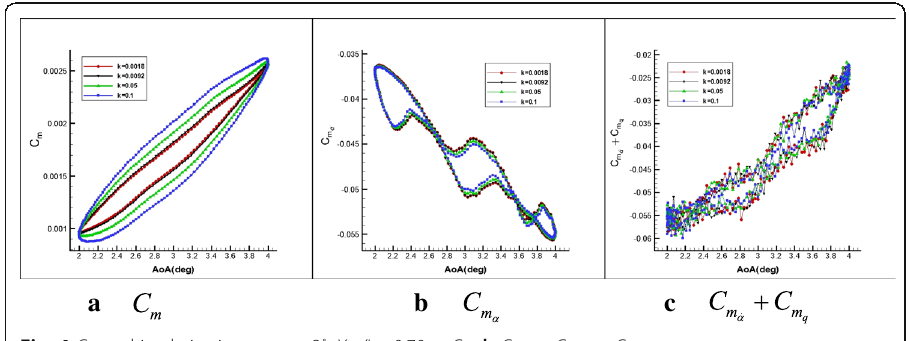
Fig. 4 C m and its derivatives at α 0 = 3 ∘ , X cg /L = 0.70. a C m . b C m